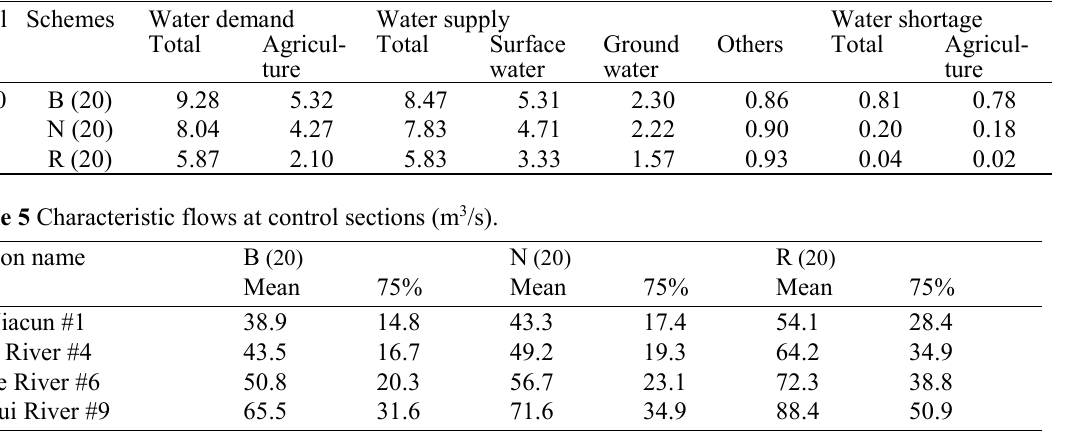
Table 4 Balance of water demand-supply (BCM).